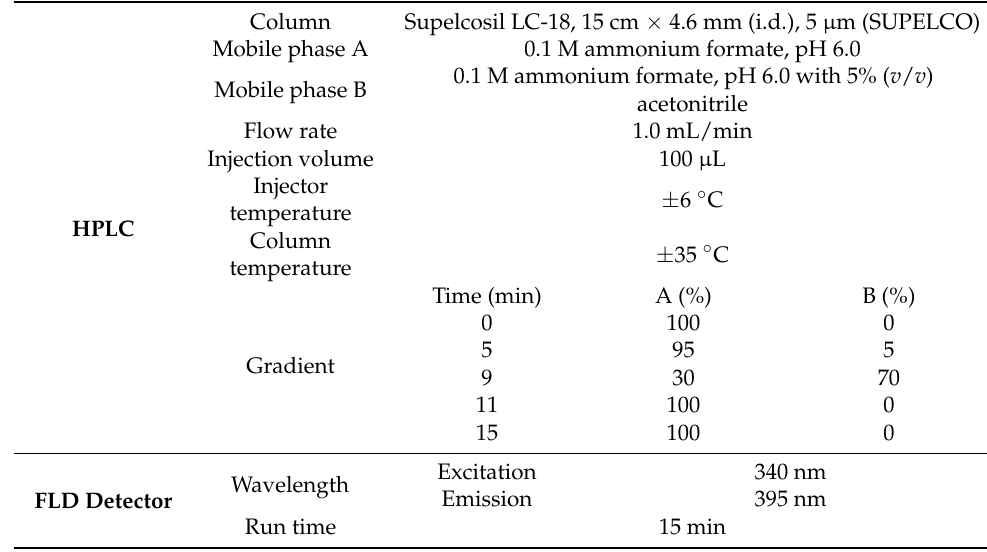
Table 3. HPLC-FLD conditions for PSTs